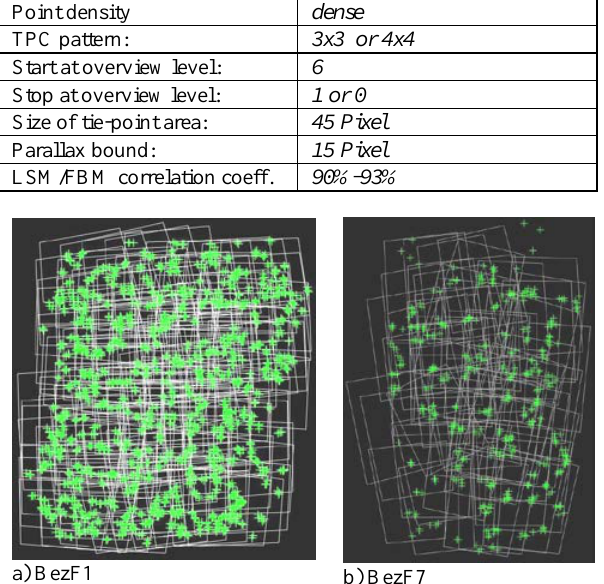
Figure 6: AT tie point distribution and image footprints.